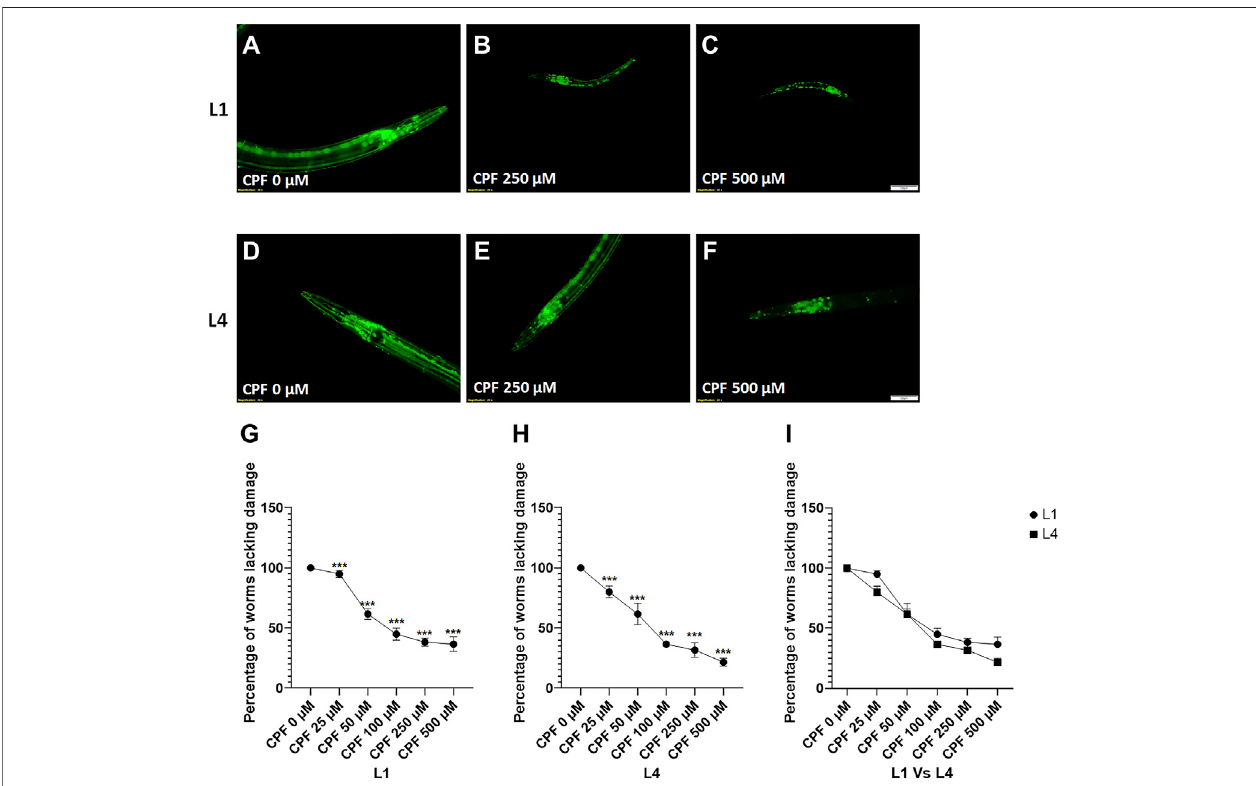
FIGURE 4 | Cholinergic neurodegeneration and its assessment: (A – C) LX929 worms at L1 stage exposed to different concentrations of CPF (0 – 500 µM). (D – F) LX929wormsatL4stagewereexposedtodifferentconcentrationsofCPF(0 – 500 µM). (G – I) Wormsexhibitingneuronaldamage,indicatedbylossofneuronordendrite breaksweremarkedasaffectedandgraphswereplottedforthepercentageofwormslackingneuronaldamageVsconcentrationforwormstreatedatL1 (G) andL4 (H) stages. (I) acomparison between theeffectson neuronaldamage for worms treated at L1 and L4 stages. A minimum of20 worms were analyzed per replicate.All experimentswereconductedinthreeindependentreplicatesDatawereanalyzedusingone-wayANOVAfollowedbyDunnett ’ sposthoctest.* p < 0.05,** p < 0.005,and *** p < 0.001( n =3).Scalebarrepresents50 µm.